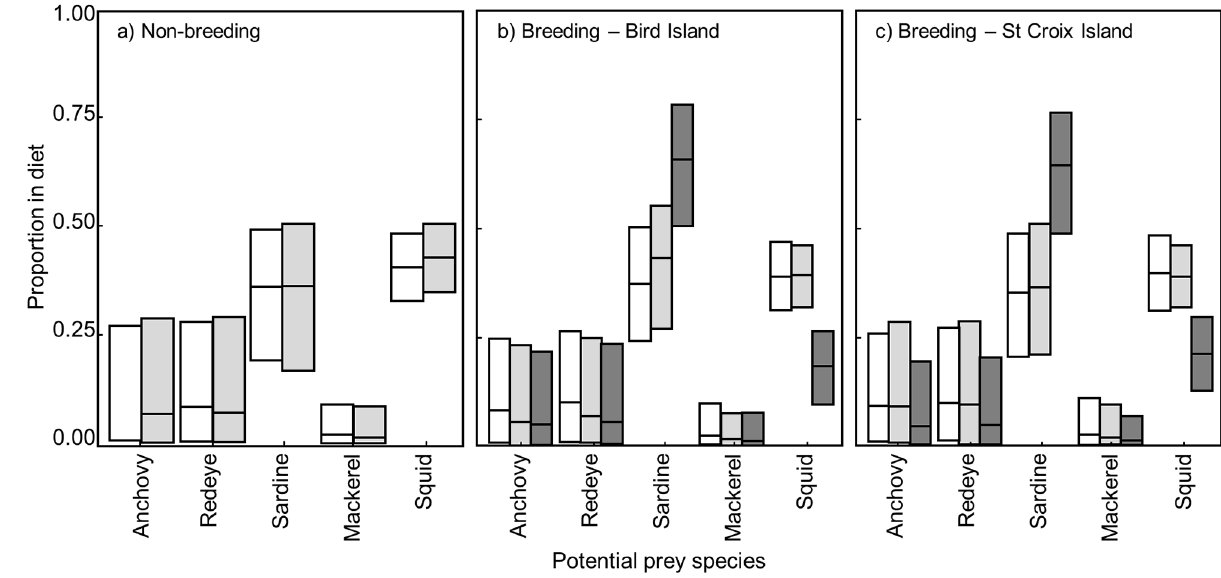
Fig 6. Stable isotope mixing model (MixSIAR) results with predicted diet proportions (median values and 5 th to 95 th percentiles) of each five potential prey species compared to δ 13 C and δ 15 N values of African penguin feathers. White: females, light grey: males, dark grey: